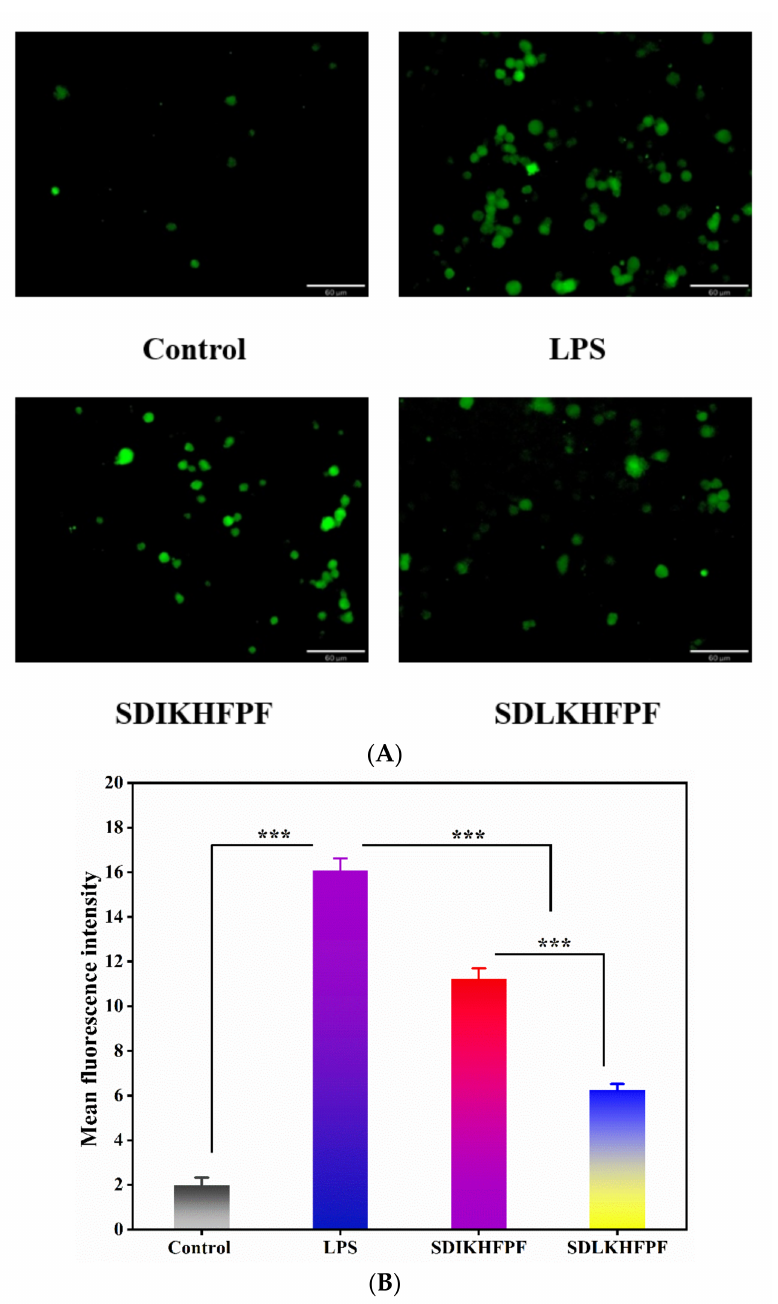
Figure 2. ( A ) Fluorescence inversion microscopy imaging of ROS in RAW264.7 macrophages. ROS labeled with DCFH-DA (green: DCFH-DA). ( B ) The mean fluorescence density of RAW264.7 macrophages. Data were represented as mean ± SD ( n = 3), ***: p <